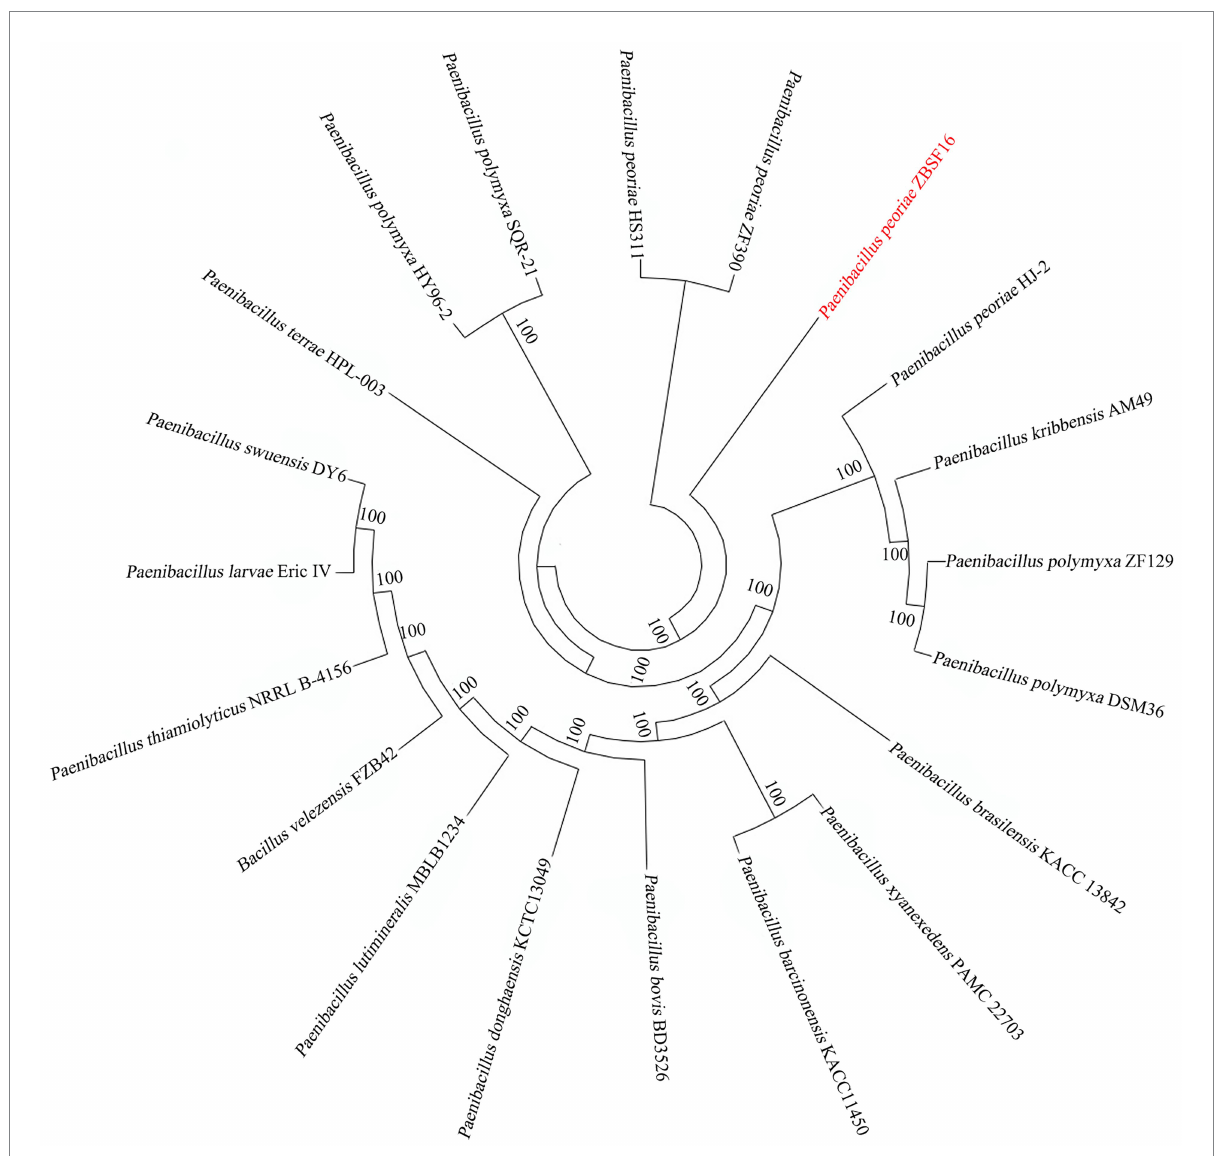
FIGURE 4 Phylogenetic analysis of Paenibacillus peoriae ZBSF16 against six other Paenibacillus from genomes using PhyloPhlAn